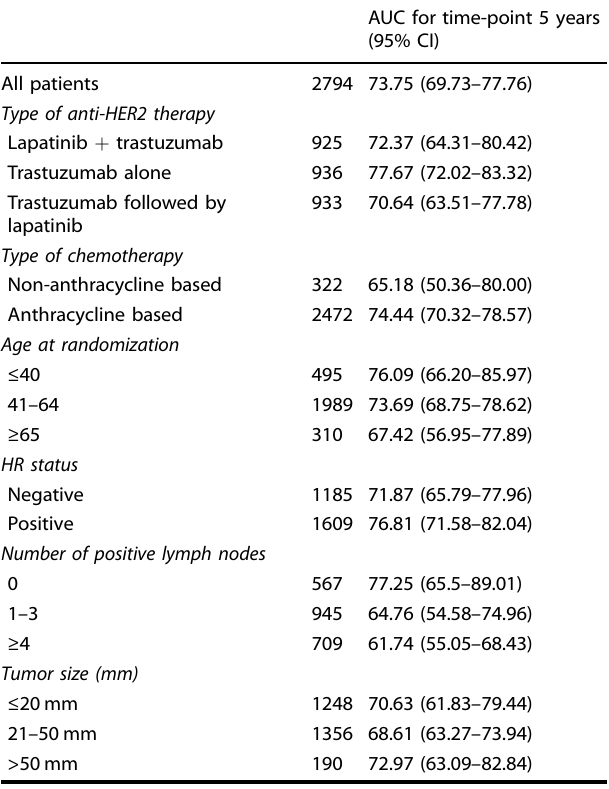
Table 3. Discriminatory accuracy of PREDICT in the overall population and in